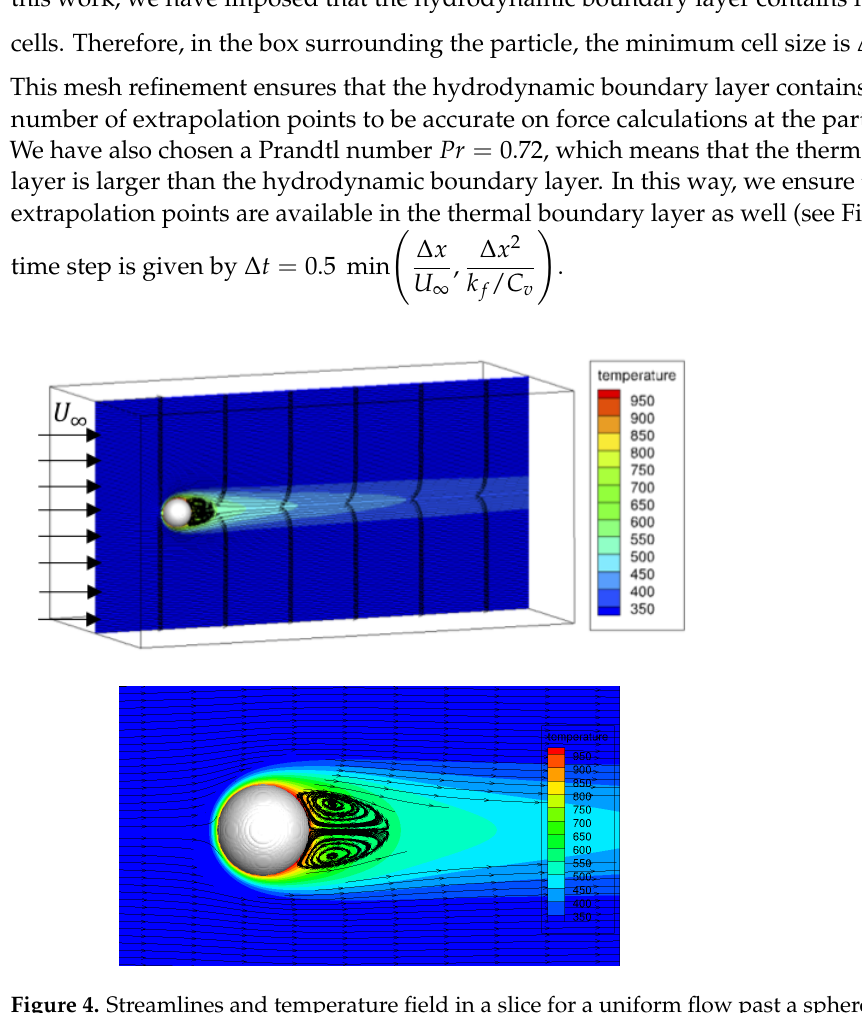
Figure 4. Streamlines and temperature field in a slice for a uniform flow past a sphere at Re = 100. The bottom figure is a zoom on the